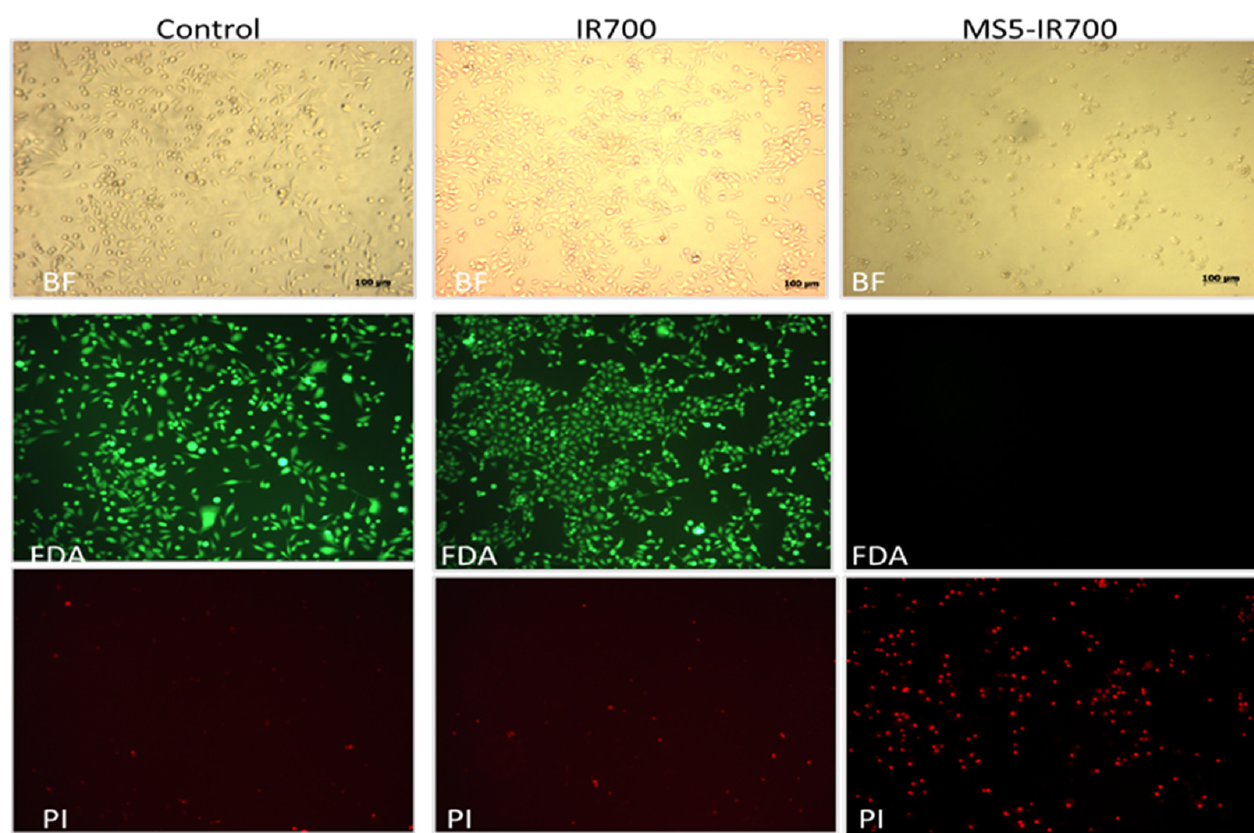
Figure 4. Cytotoxicity of the MS5-IR700 on PC3 cells. Experimental conditions are as in Figure 3. Light fluorescence microscopy images of cells counter-stained with FDA and PI were taken 6 h post-NIR irradiation. Scale bars present 100 µ m. BF, bright